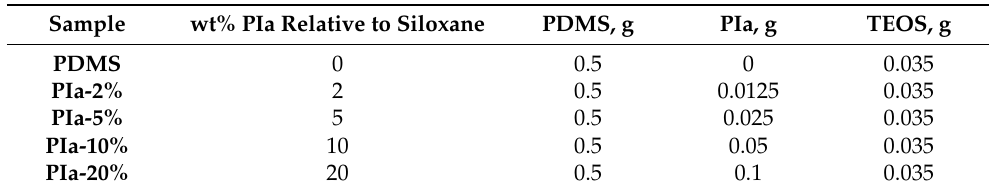
Table 1. Composition of the samples tested.